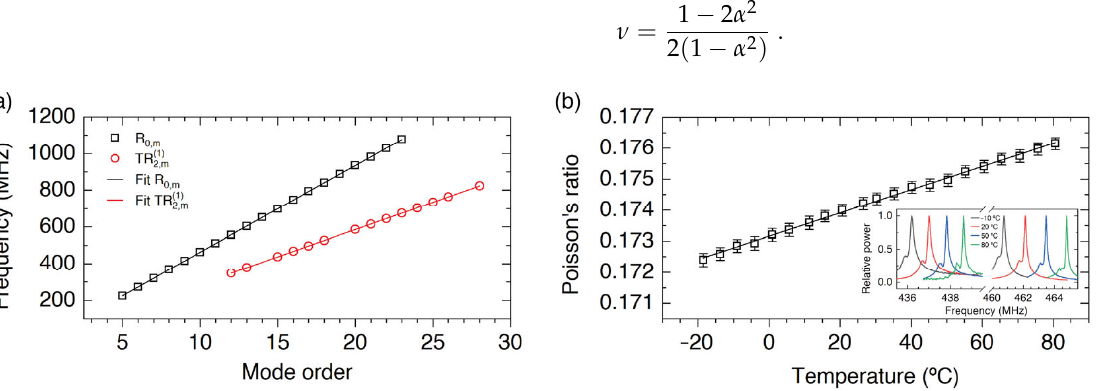
(cid:3040)(cid:4666)(cid:2869)(cid:4667) , resonances ver ‐ ( 1 ) , resonances versus (cid:2870) , 2, m